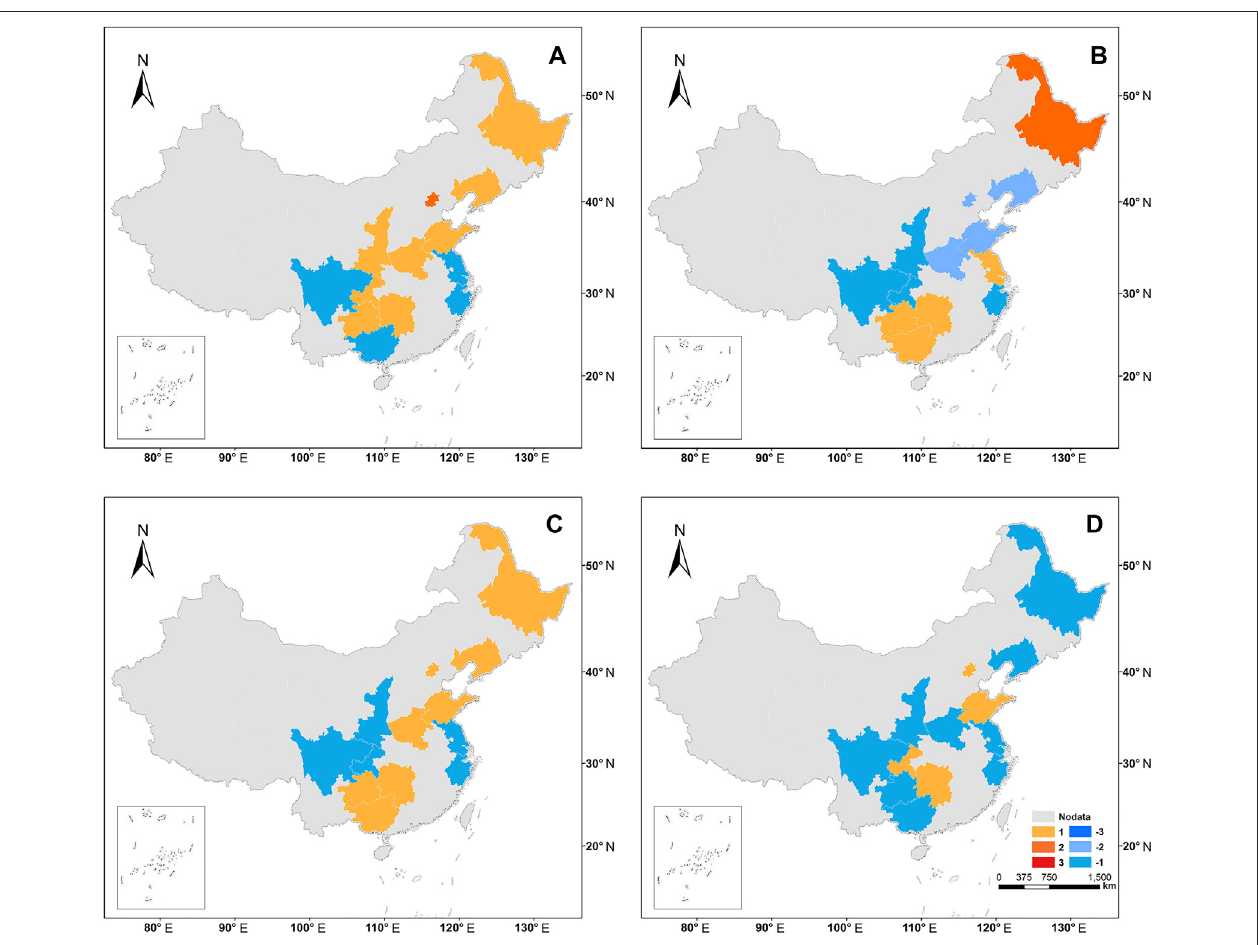
FIGURE 6 | The effect of factors on the length of the growing season. Orange is negative, and green is positive. (A) Spatial distribution of the relationship between temperature and the length of the growing season. (B) Spatial distribution of the relationship between precipitation and the length of the growing season. (C) Spatial distribution of the relationship between GDP and the length of the growing season. (D) Spatial distribution of the relationship between population and the length of the growing season. The light gray areas in the fi gures represent the areas with no data. The blue area represents the declining trend, while the red area represents the increasing trend, and the color from light to dark indicates the increasing signi fi cance ( ± 1: p > 0.05, ± 2: p < 0.05, ± 3: p < 0.01).